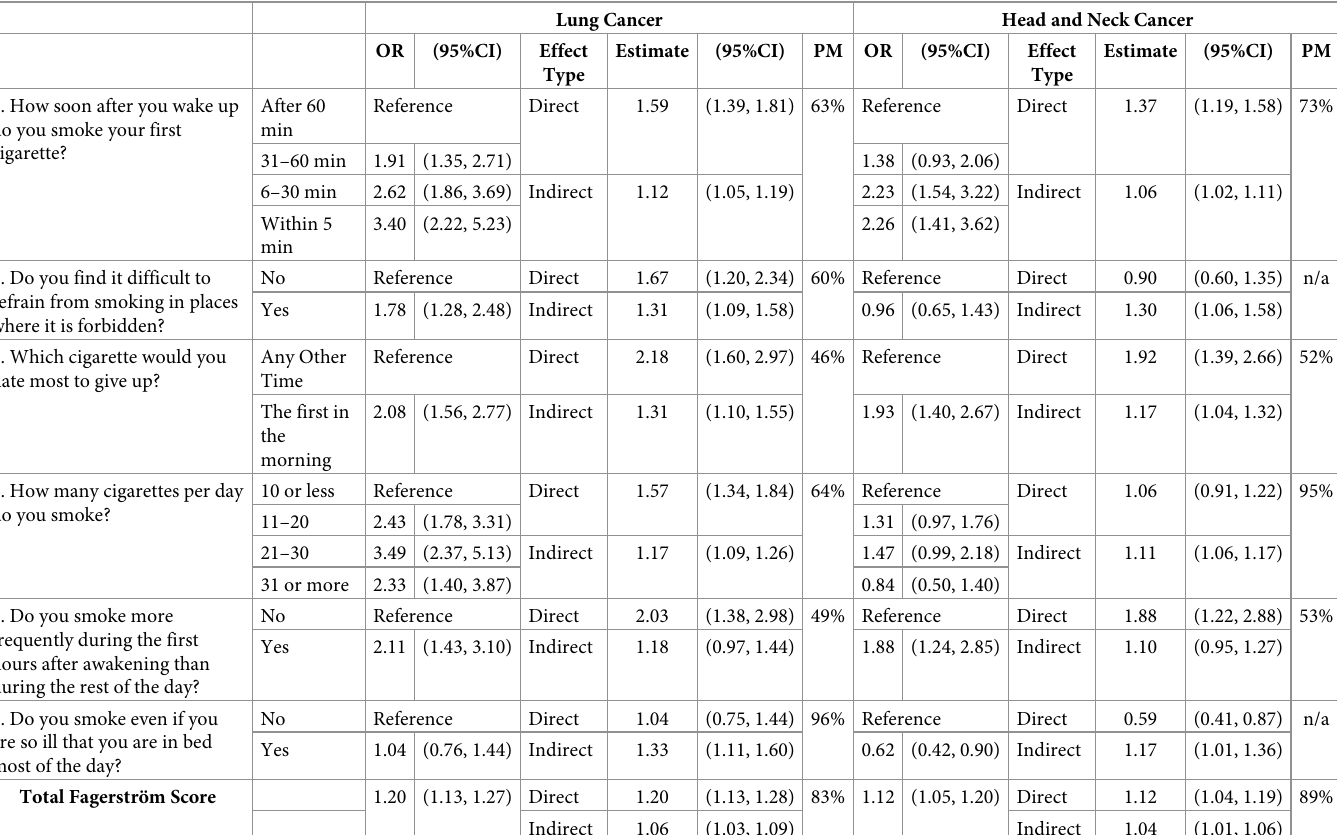
Table 2. The Effect of nicotine dependence on the risk of lung cancer and head and neck cancer separately, mediated through duration of